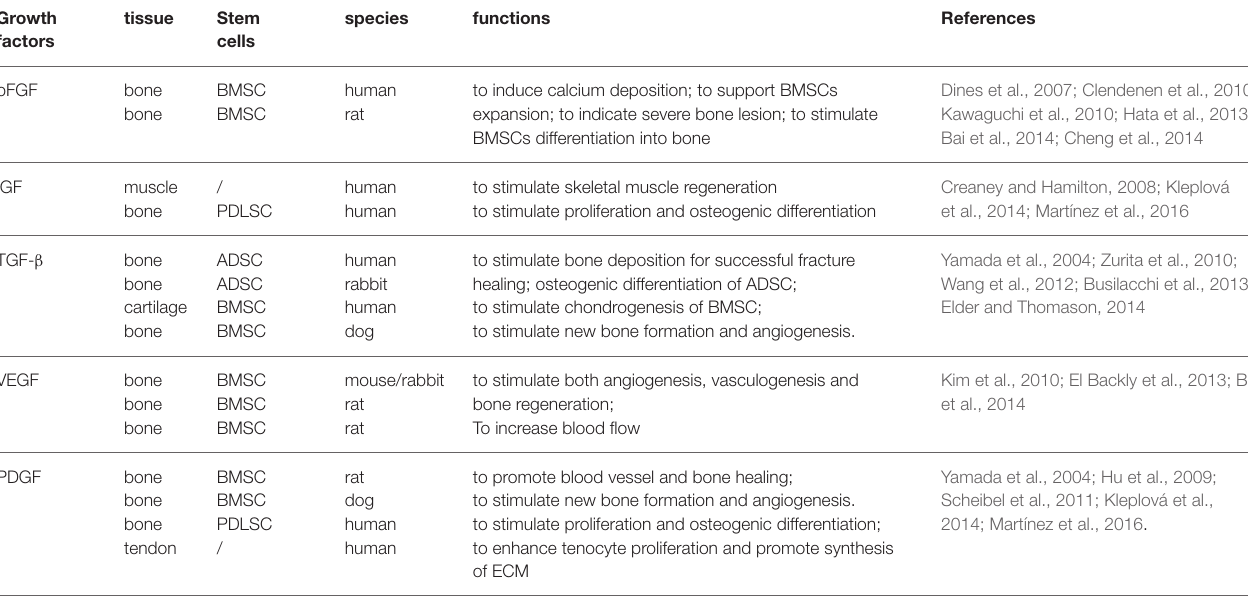
TABLE 1 | Platelet-rich plasma derived Growth factors and their applications in musculoskeletal regeneration. Growth